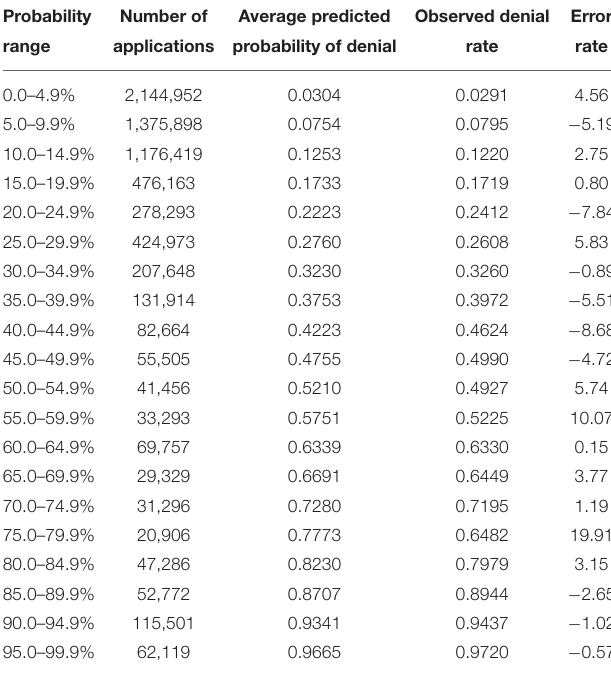
TABLE 4 | Detailed fit for loan denial model,